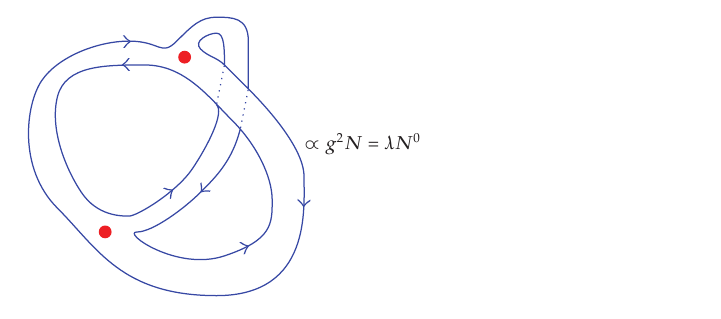
(cid:7) (cid:7) λ , E − V or E − F is not a topological invariant and depends on the triangulation (cid:2) Feynman diagram (cid:3)